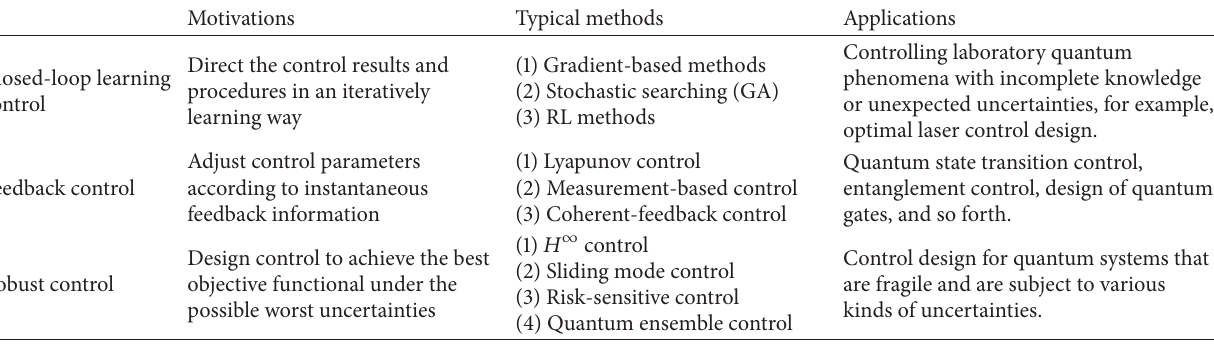
Table 1: Closed-loop and robust control approaches for quantum systems.